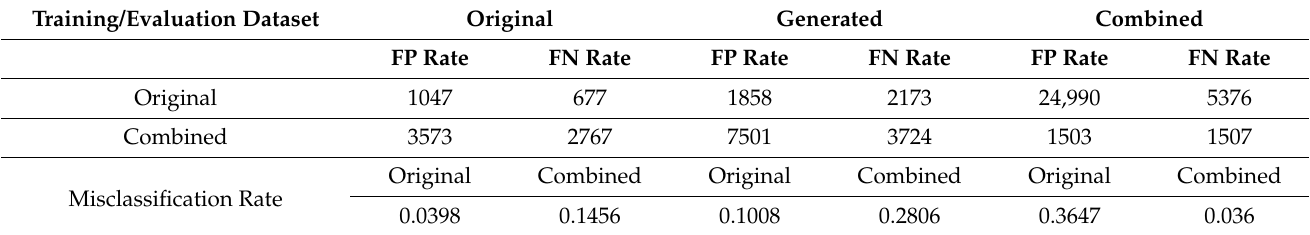
Table 6. False Positives (FP), False Negatives (FN) and Misclassification Rates for the original and combined datasets.